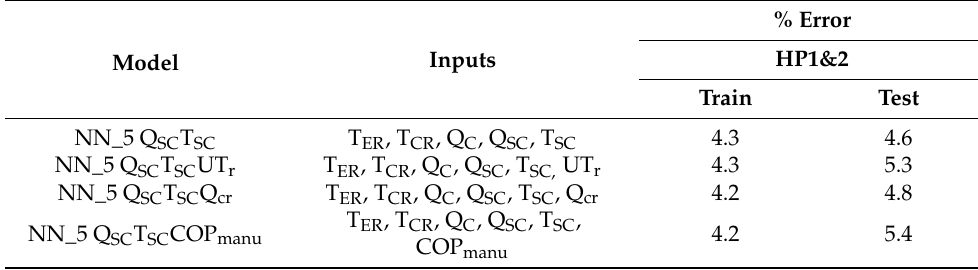
Table 8. Step 3 of forward